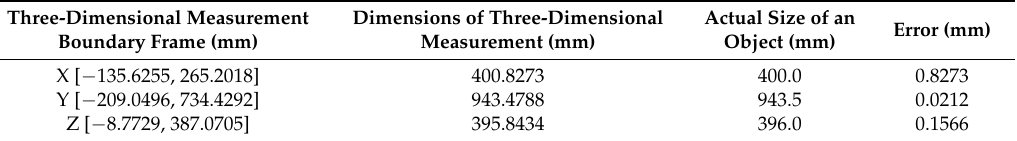
Table 3. Comparison of the three-dimensional reconstruction measurements of body parts and the actual size of the Terra-Cotta Warriors.